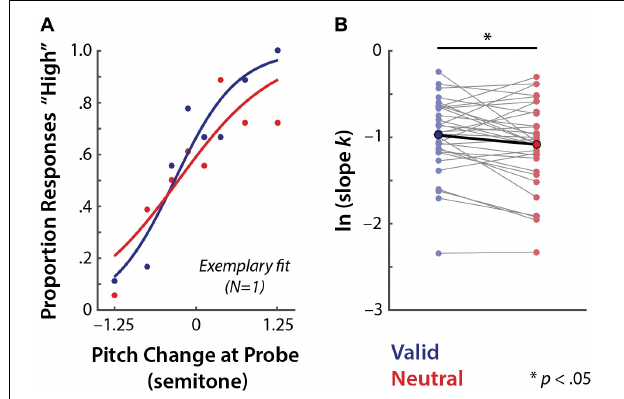
FIGURE 4 | Perceptual precision in valid vs. neutral retro-cue conditions. (A) An exemplary ( N = 1) psychophysical modeling results. Dots represent the actual data points and lines indicate model-estimated fits (see Supplementary Figure S1 for all individual participants’ fits). (B) All ( N = 32) individuals’ overall perceptual precision estimates of the valid and neutral retro-cue trials (thin gray lines; ln k ) and the mean across individuals (bold